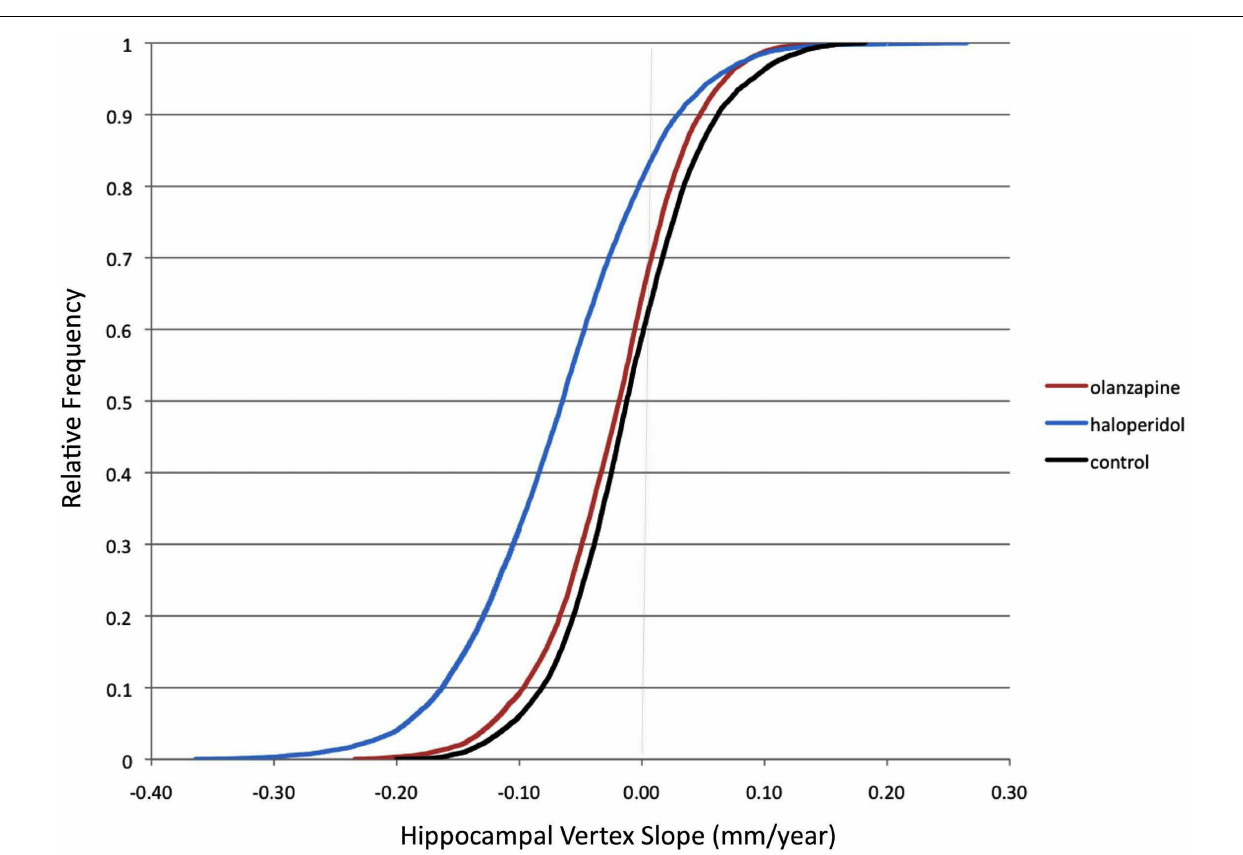
FIGURE 2 | Cumulative distribution functions of hippocampal surface vertices. Group distributions of mean slope (mm/year) across the 13,222 hippocampal surface vertices (left and right combined) are shown. Slopes